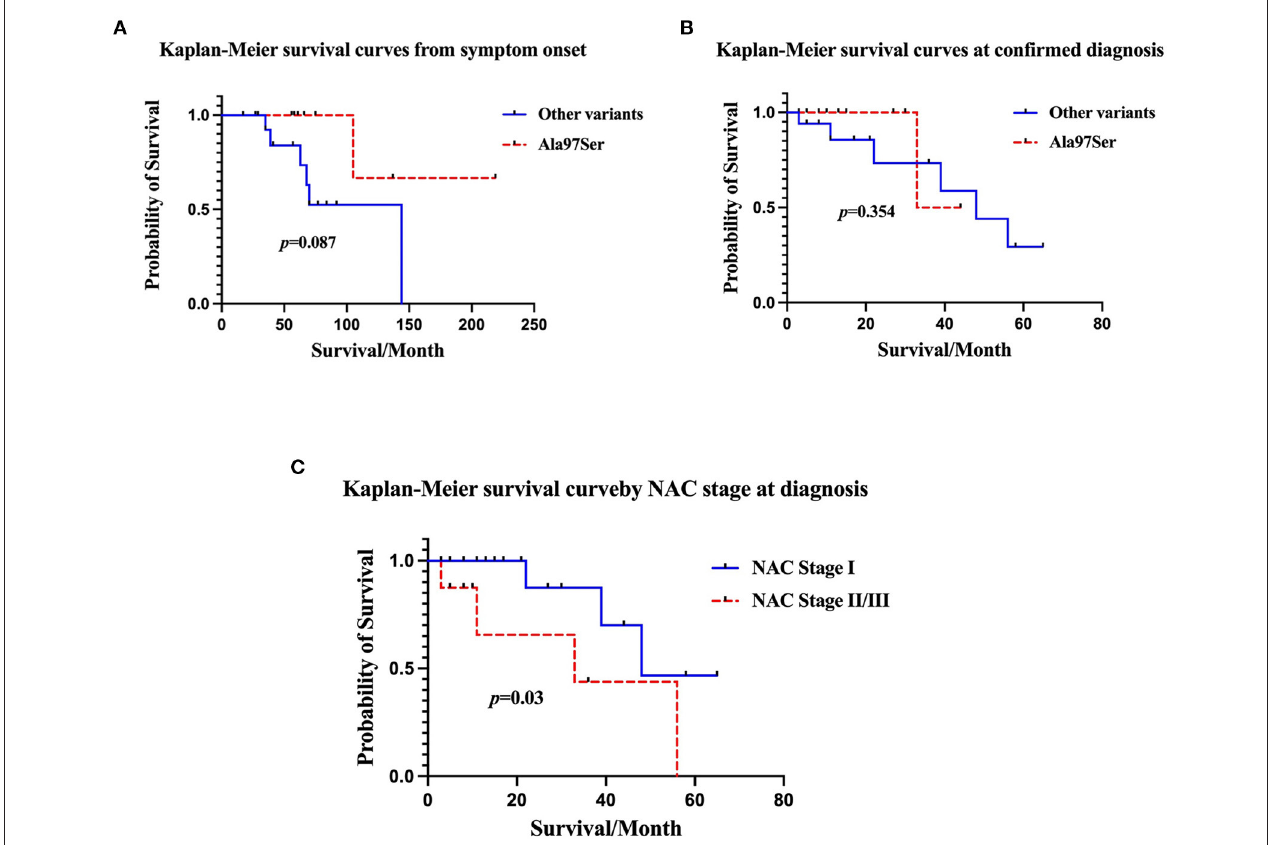
FIGURE 3 | (A) Comparison of Kaplan-Meier survival curves of data obtained from ATTR-CA symptom onset between patients with Ala97Ser and other variants. There was no significant difference in survival in patients with Ala97Ser and other variants [Breslow (Generalized Wilcoxon), χ 2 = 2.92, p = 0.087]. (B) Comparison of Kaplan-Meier survival curves at confirmed diagnosis between patients with Ala97Ser and other variants. Survival after diagnosis was not significantly different in patients with Ala97Ser and other variants [Breslow (Generalized Wilcoxon), χ 2 = 0.859, p = 0.35]. (C) Kaplan-Meier survival curve for patients grouped by NAC stage at diagnosis. Patients with NAC stage II/III disease had worse survival than those with NAC stage I disease [Breslow (Generalized Wilcoxon), χ 2 = 4.693, p = 0.03)]. The median survival time of patients in NAT stage I was 48 months (95%CI 39–63) and the cumulative survival at 60 months was 46.7%. The median survival time of patients in NAC stage II/III was 33 months (95%CI 13.7–55.3) and the cumulative survival at 60 months was